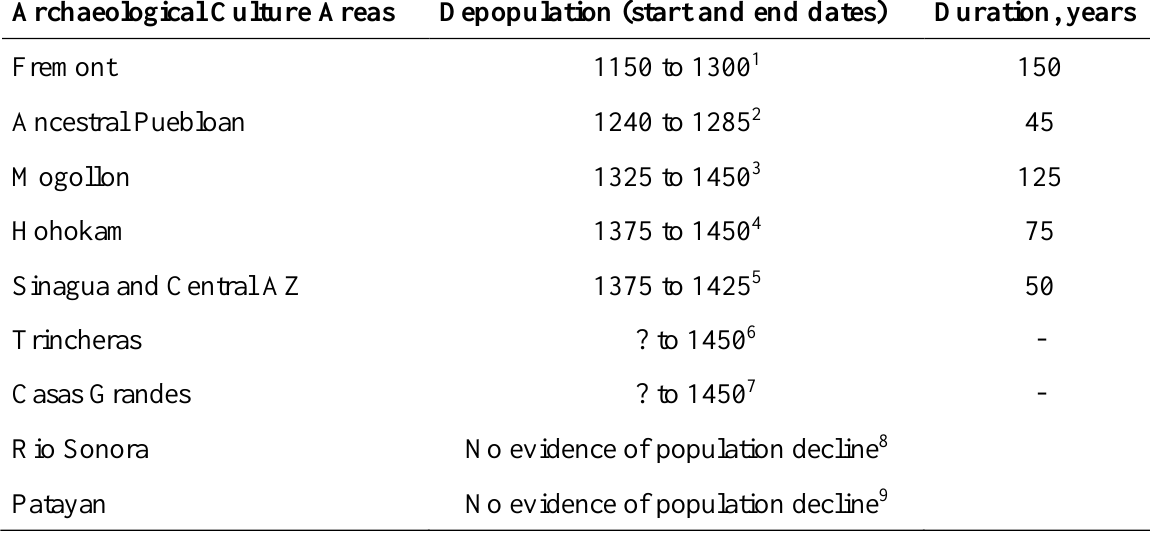
Table A3.1. Table 1. Depopulation dates, notes, and